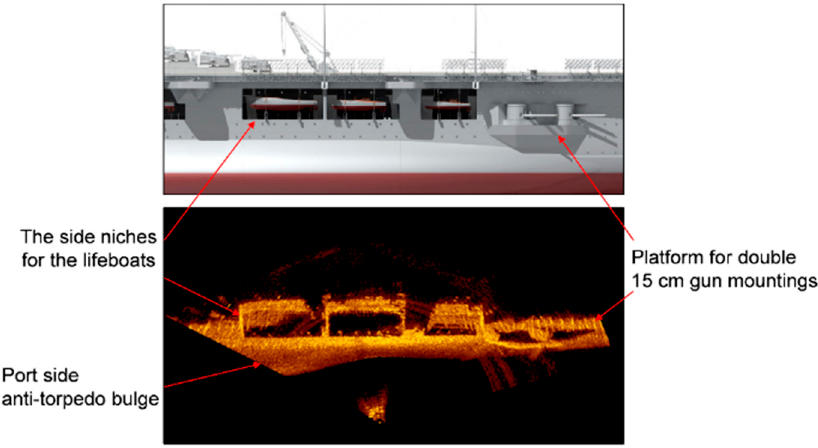
Figure 20. Side niches situated on the port side of the aircraft carrier.